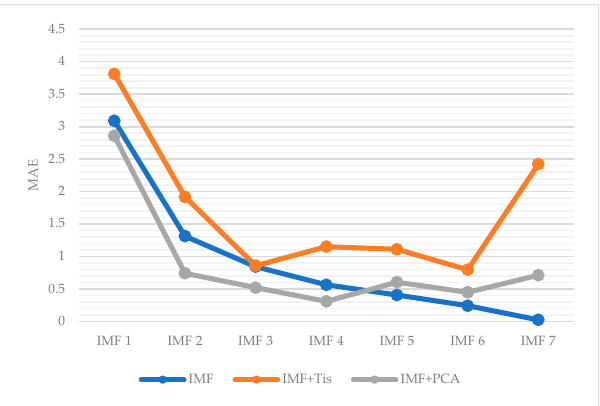
Appl. Sci. 2022 , 12 , 10823 Figure 9. The MAE result applies an additional input feature to each IMF of the EMD-LSTM.